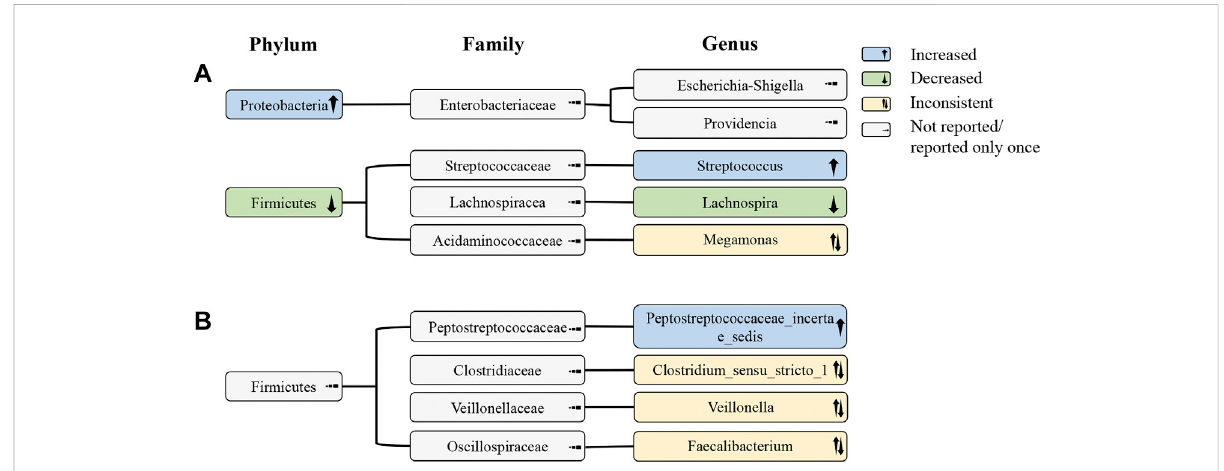
FIGURE 3 Alterationsof gutmicrobiota atthephylum,family,and genus levels inIMN patients. (A) AlterationsofgutmicrobiotainIMN patients compared with HCs; (B) alterations of gut microbiota in IMN patients relative to HCs and DKD. IMN, idiopathic membranous nephropathy; HCs, healthy controls; DKD, diabetic kidney